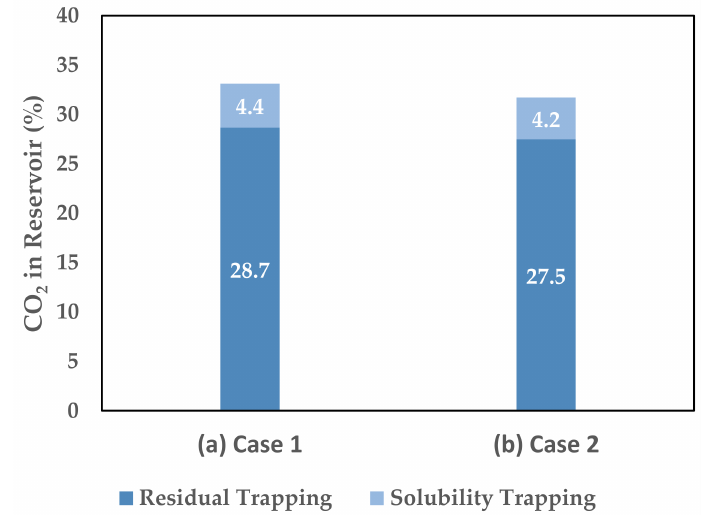
Figure 11. The comparison of trapping index: ( a ) Case 1, ( b ) Case